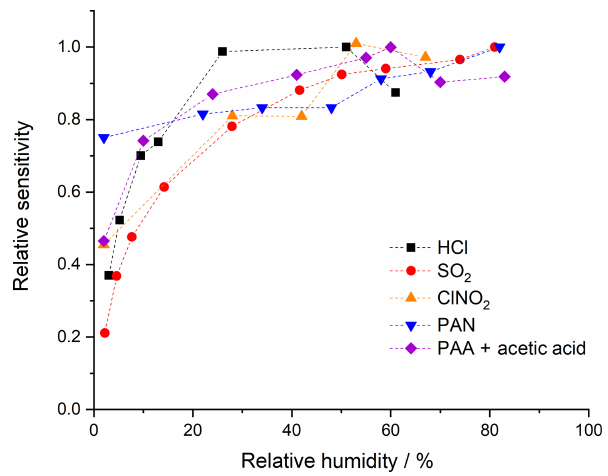
Figure 5. Dependence of the ion signal on the relative humidity (at 25 ◦ C and 1bar) of the air sampled. For PAA + acetic acid on m/z 59 only a combined humidity dependence is given as their con- tributions to the signal could not reliably be